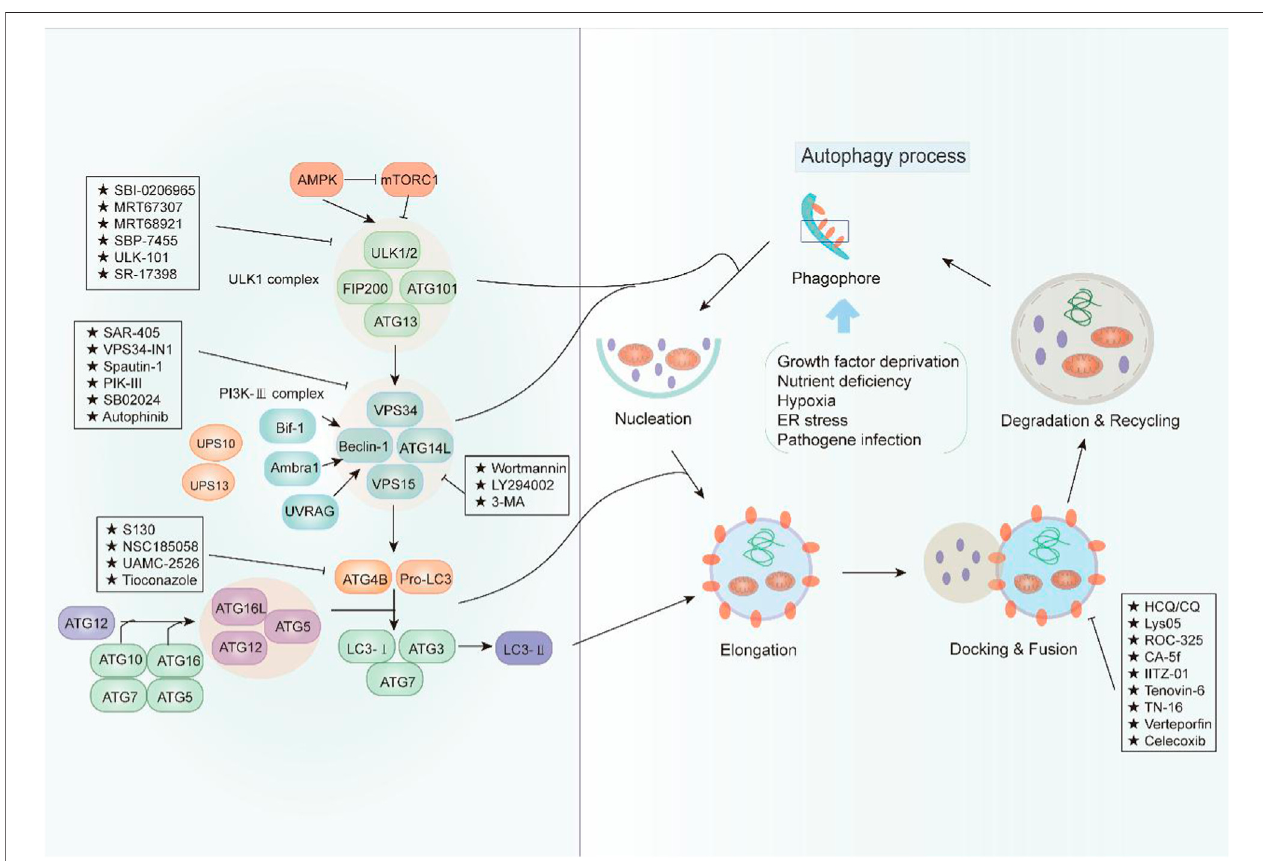
FIGURE 1 | An overview of the modulation of autophagy. The initiation of autophagy is controlled by the ULK1 kinase complex that integrates stress signals from mTORC1 and AMPK. When mTORC1 kinase activity is inhibited, ULK1 is activated and binding with multiple ATG proteins like ATG101, ATG13, and FIP200 to engage the formation of phagophore. Then, the ULK1 complex activates the autophagosome formation by the phosphorylation of VPS34 and Beclin-1, which forms a PI3K-III complex. Beclin 1 interacts with factors (Ambra1, Bif-1, UVRAG, and ATG14L) that modulate its binding to VPS34 whose lipid kinase activity is essential for autophagy. Cellular concentrations of the initiation complex are also under the control of an ubiquitination cascade regulated by the deubiquitination peptidases USP10and USP13.Inaddition, theLC3systemisrequiredforautophagosome transportandmaturation.Intheautophagosomematuration, pro-LC3 couldbecleaved by ATG4B with assistance of ATG3 and ATG7 aswell as ATG5, ATG12, and ATG16. Mature autophagosomes fuse with lysosomes to degradetheir cargo, and recycle essential biomolecules. Some small-molecule compounds can suppress autophagy by targeting early or late stages in the pathway.